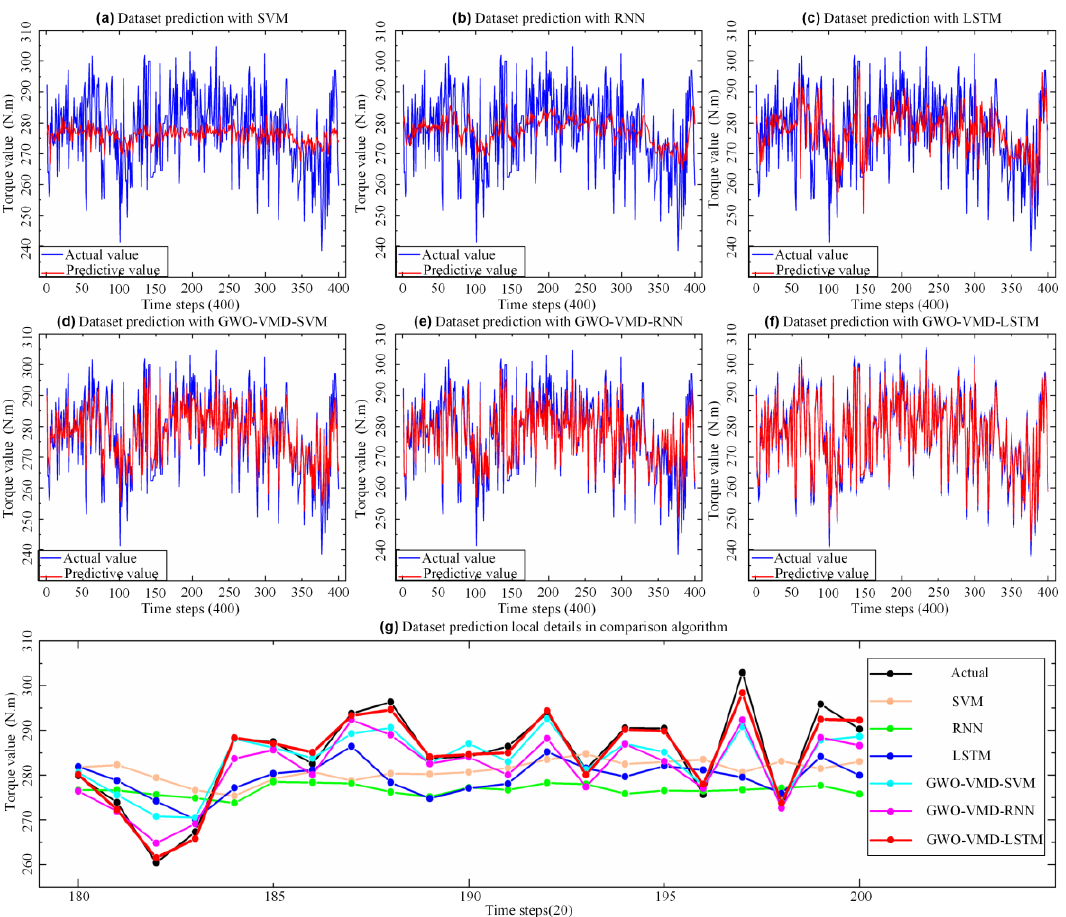
Figure 9. Prediction effects of different models on selected datasets.